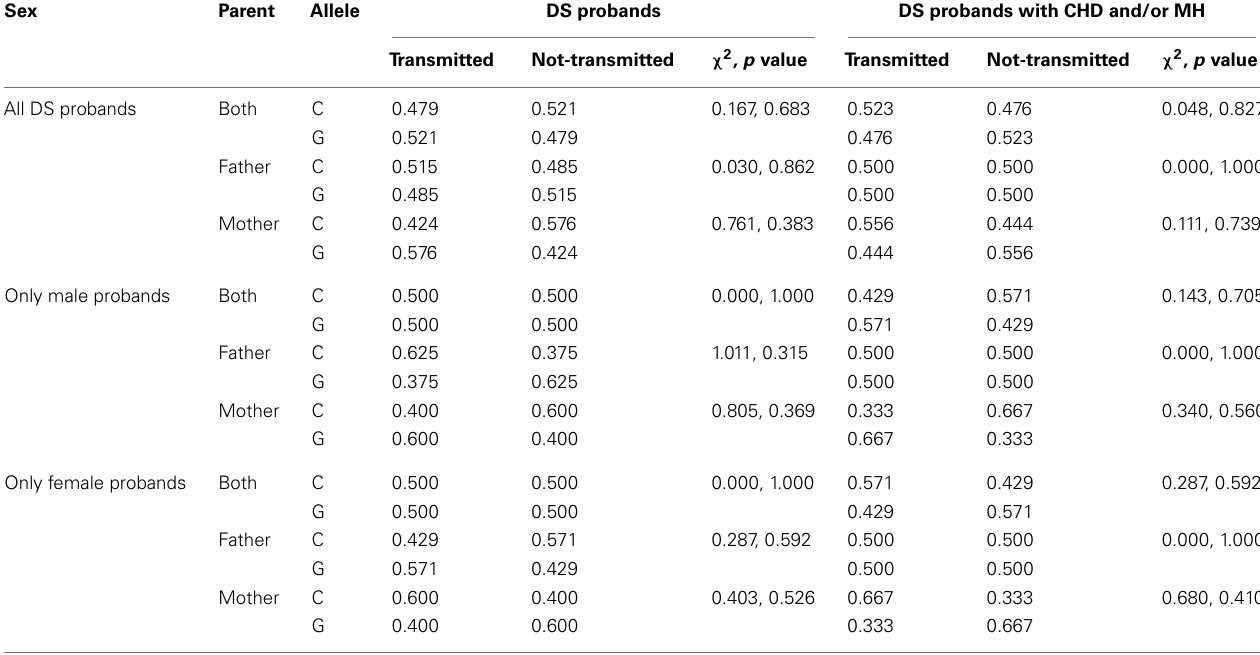
Table 4 | Frequency of rs2270669 allele transmission in families with DS probands.